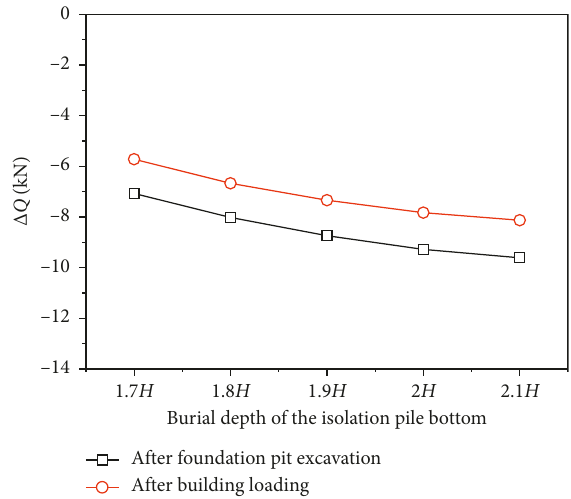
Figure 33: Difference between the additional shear forces.